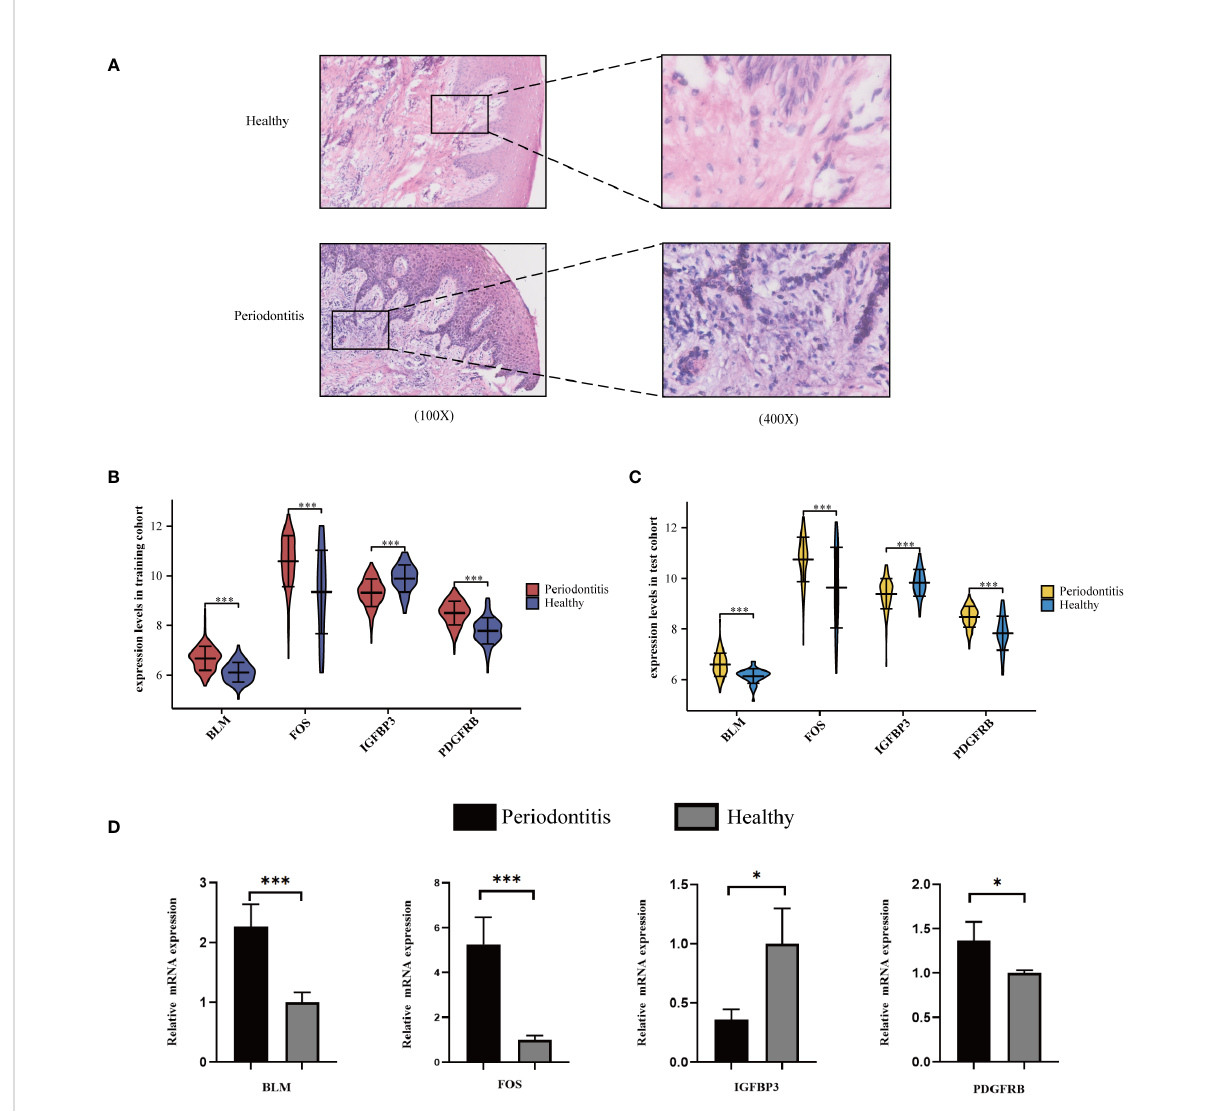
FIGURE 5 Validation of hub ARGs. (A) Representative images of HE staining of human periodontal tissues. (B) The expression status of the four hub ARGs was presented in the form of a violin diagram in the training cohort and (C) test cohort. (D) The qRT-PCR validation of the four hub ARGs (*p< .05; ***p<